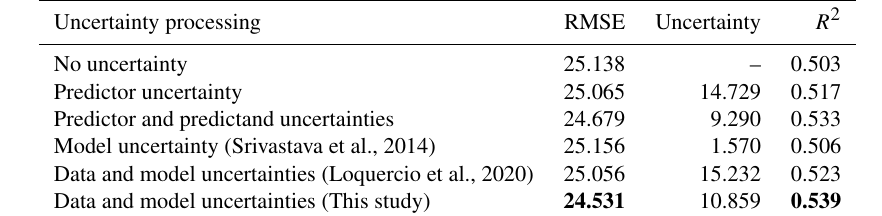
Table 2. The accuracy of precipitation forecasting based on different uncertainty processing strategies. The best RMSE and the highest R 2 are shown in bold for each column.